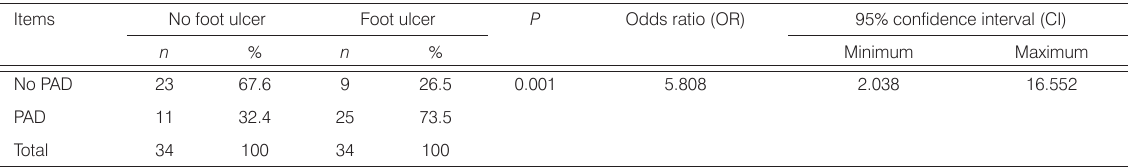
Table 2. Relationship between peripheral artery disease (PAD) and the incidence of diabetic foot ulcers in the general hospital of Dr. Moewardi Surakarta on December